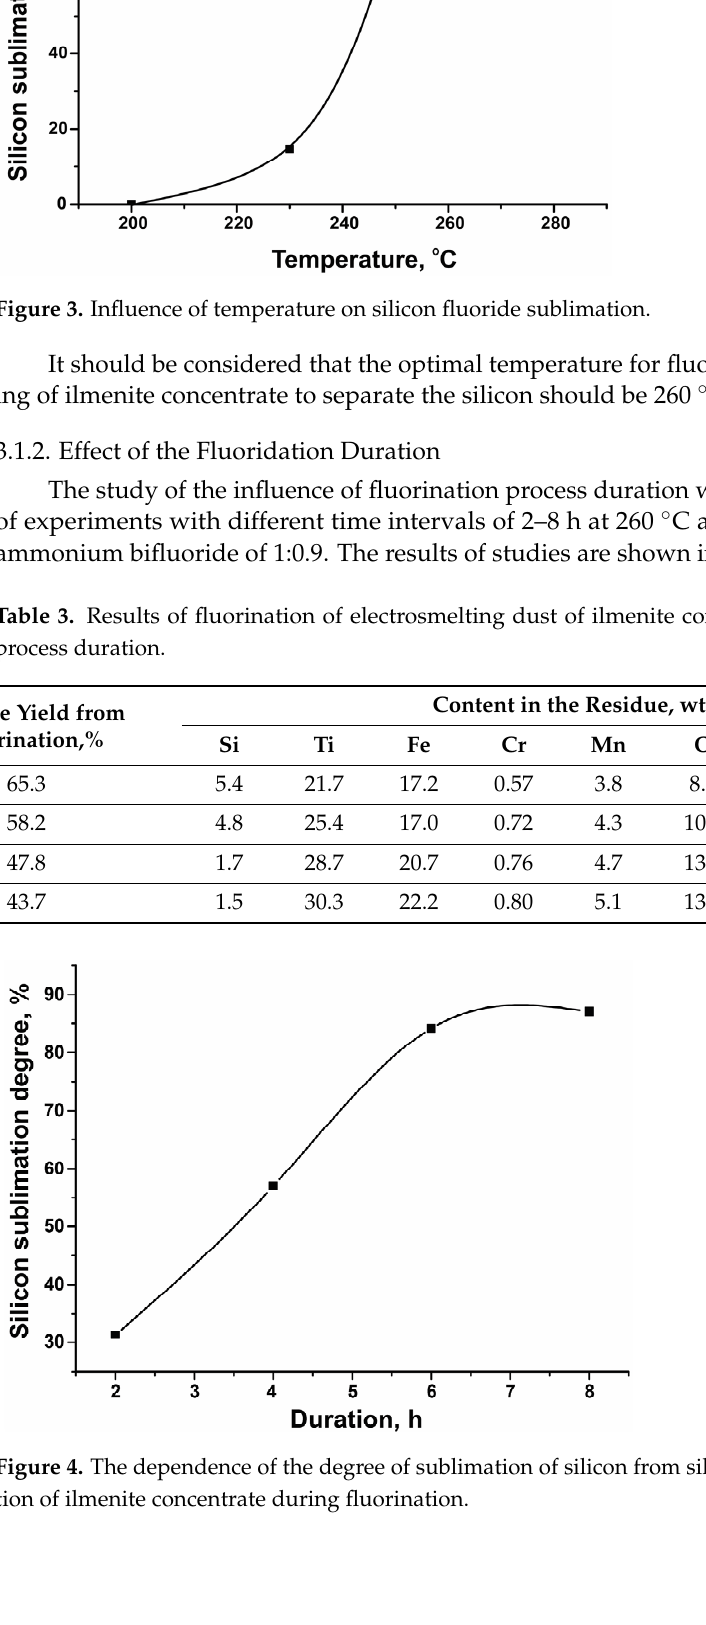
Figure 5. A diffractogram of the residue from fluorination of electrosmelting dust of ilmenite concentrate (2 h, 260 ° С , dust : NH 4 HF 2 = 1 : 0.9). An increase in the fluorination duration up to 6 h allowed almost complete extraction of silicon in the sublimations (Figure 6) [32].